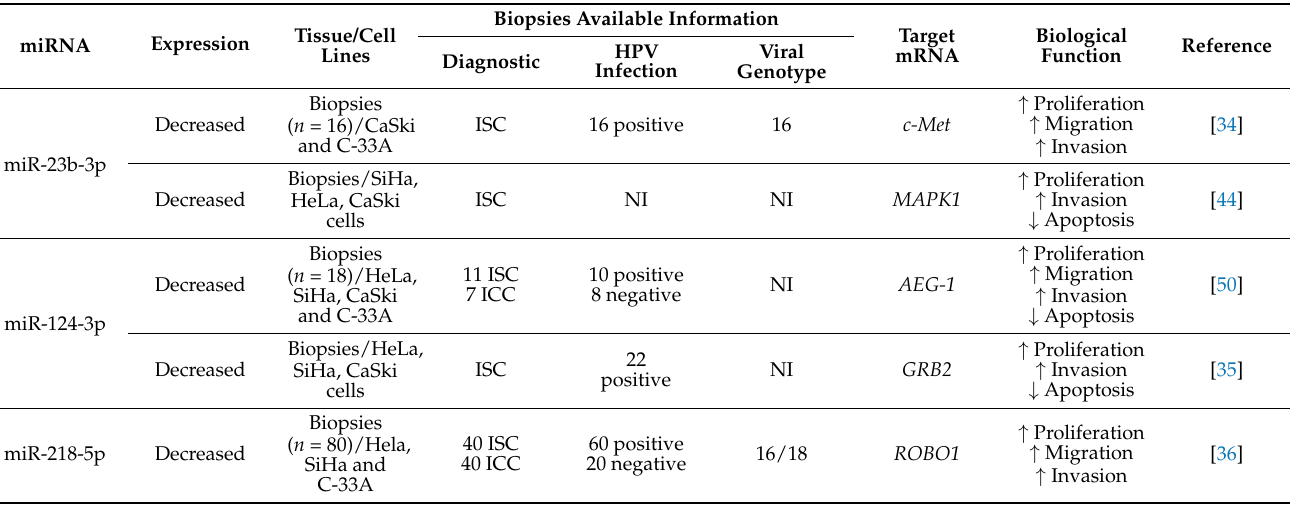
Table 1. miRNAs involved in the progression of cervical cancer, detected in biopsies with or without HPV infection and in cell